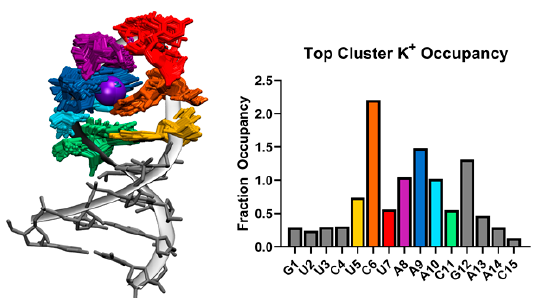
Figure 4. Left: 100 frames from the top cluster from cluster analysis of all SL3 MD simulations overlapped with K + ion density (purple sphere) at 80% occupancy. Right: Fraction occupancy of K + ions for each SL3 residue from the top cluster trajectory. Colors of loop residues UCUAAAC match between the structure and bar graph.